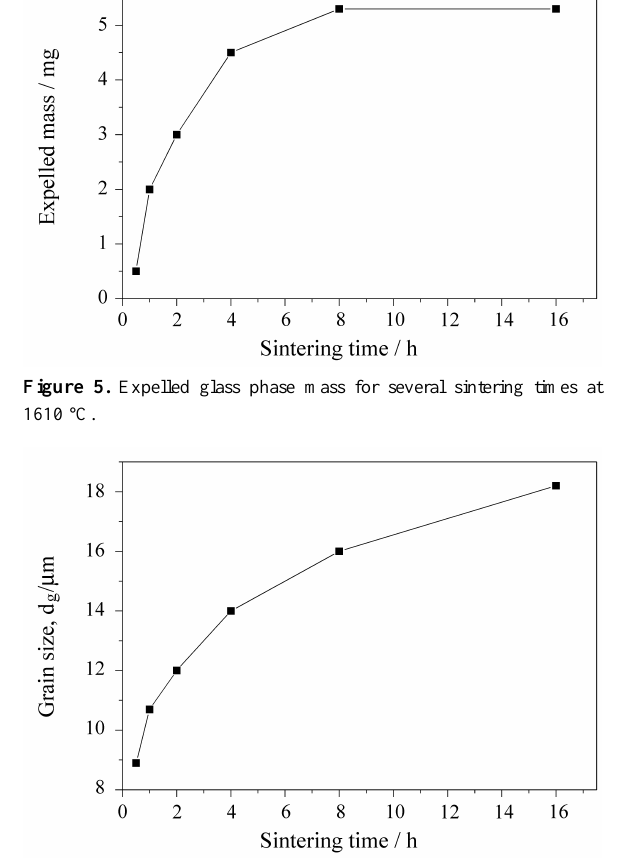
Figure 7. Characteristic glass phase distribution in the grain boundaries after sintering at 1610 °C Thin and thick regions are